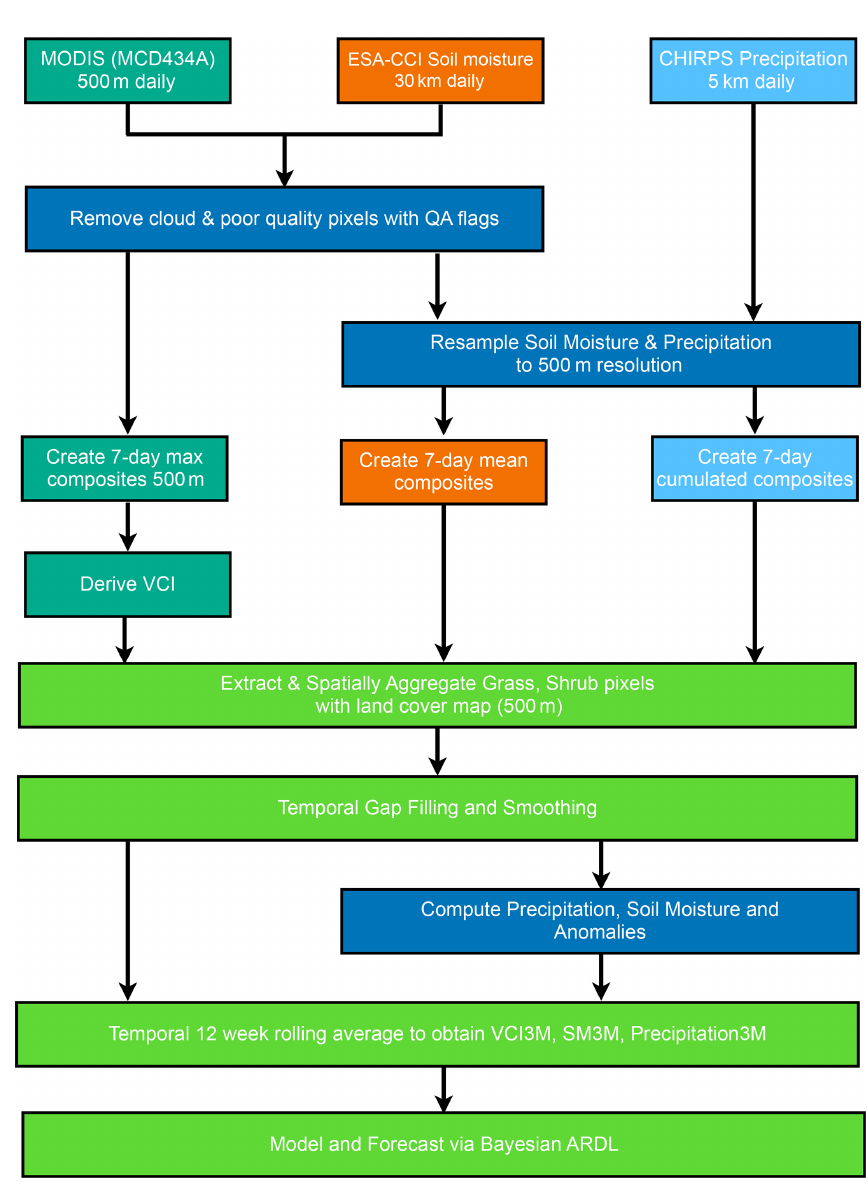
Figure 2. A flow chart showing a summary of the data pre-processing and modelling steps detailed in Sects. 3 and